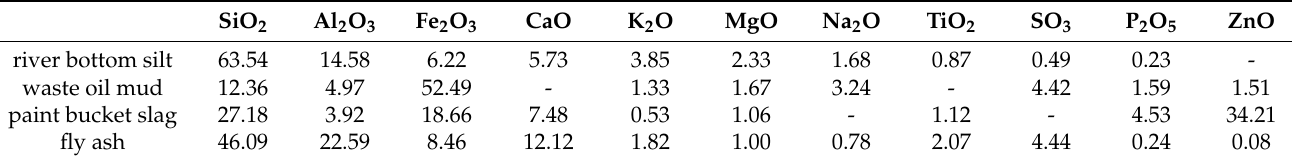
Table 1. Chemical component analyses of raw materials (wt.%).